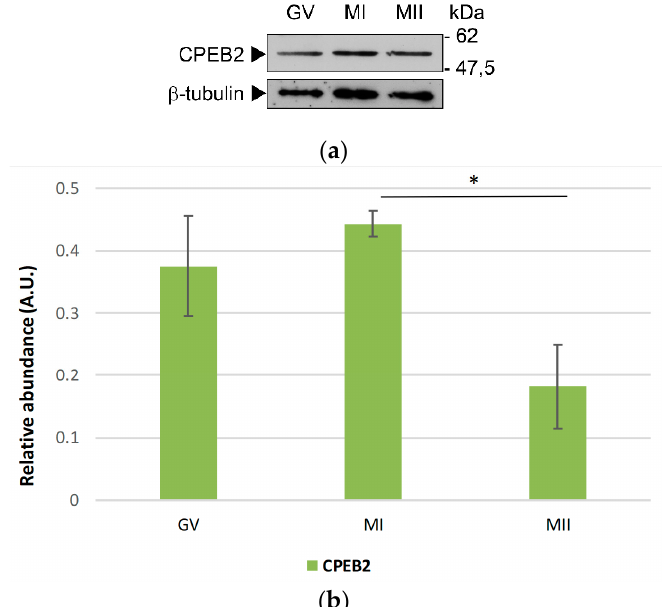
Figure 3. Relative protein expression of CPEB2 during the meiotic maturation of porcine oocytes. ( a ) Representative images from WB probed by antibodies for CPEB2 and β -tubulin proteins in the GV, MI, and MII oocytes. β -tubulin was used as a loading control. The experiment was performed three times, with 100 oocytes per experiment. ( b ) The protein expression of CPEB2 from three independent experiments was quantified using Quantity One software. The density of each individual band was normalized to the total density of the examined bands and to β –tubulin. The value of CPEB2 was summed. The values represent the means ± SEM and * indicates statistical difference ( p < 0.05).